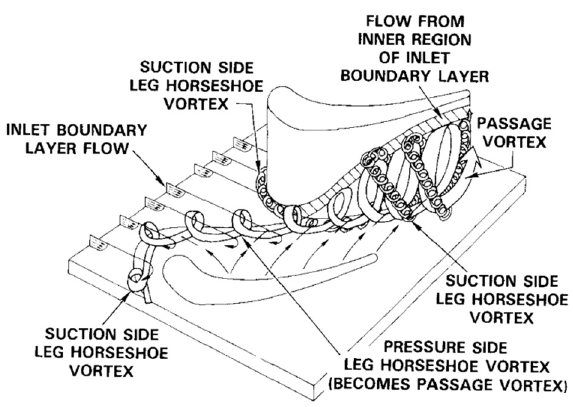
Figure 4. Three-dimensional flow field in the end wall region: secondary flow vortex structure as proposed by [42].